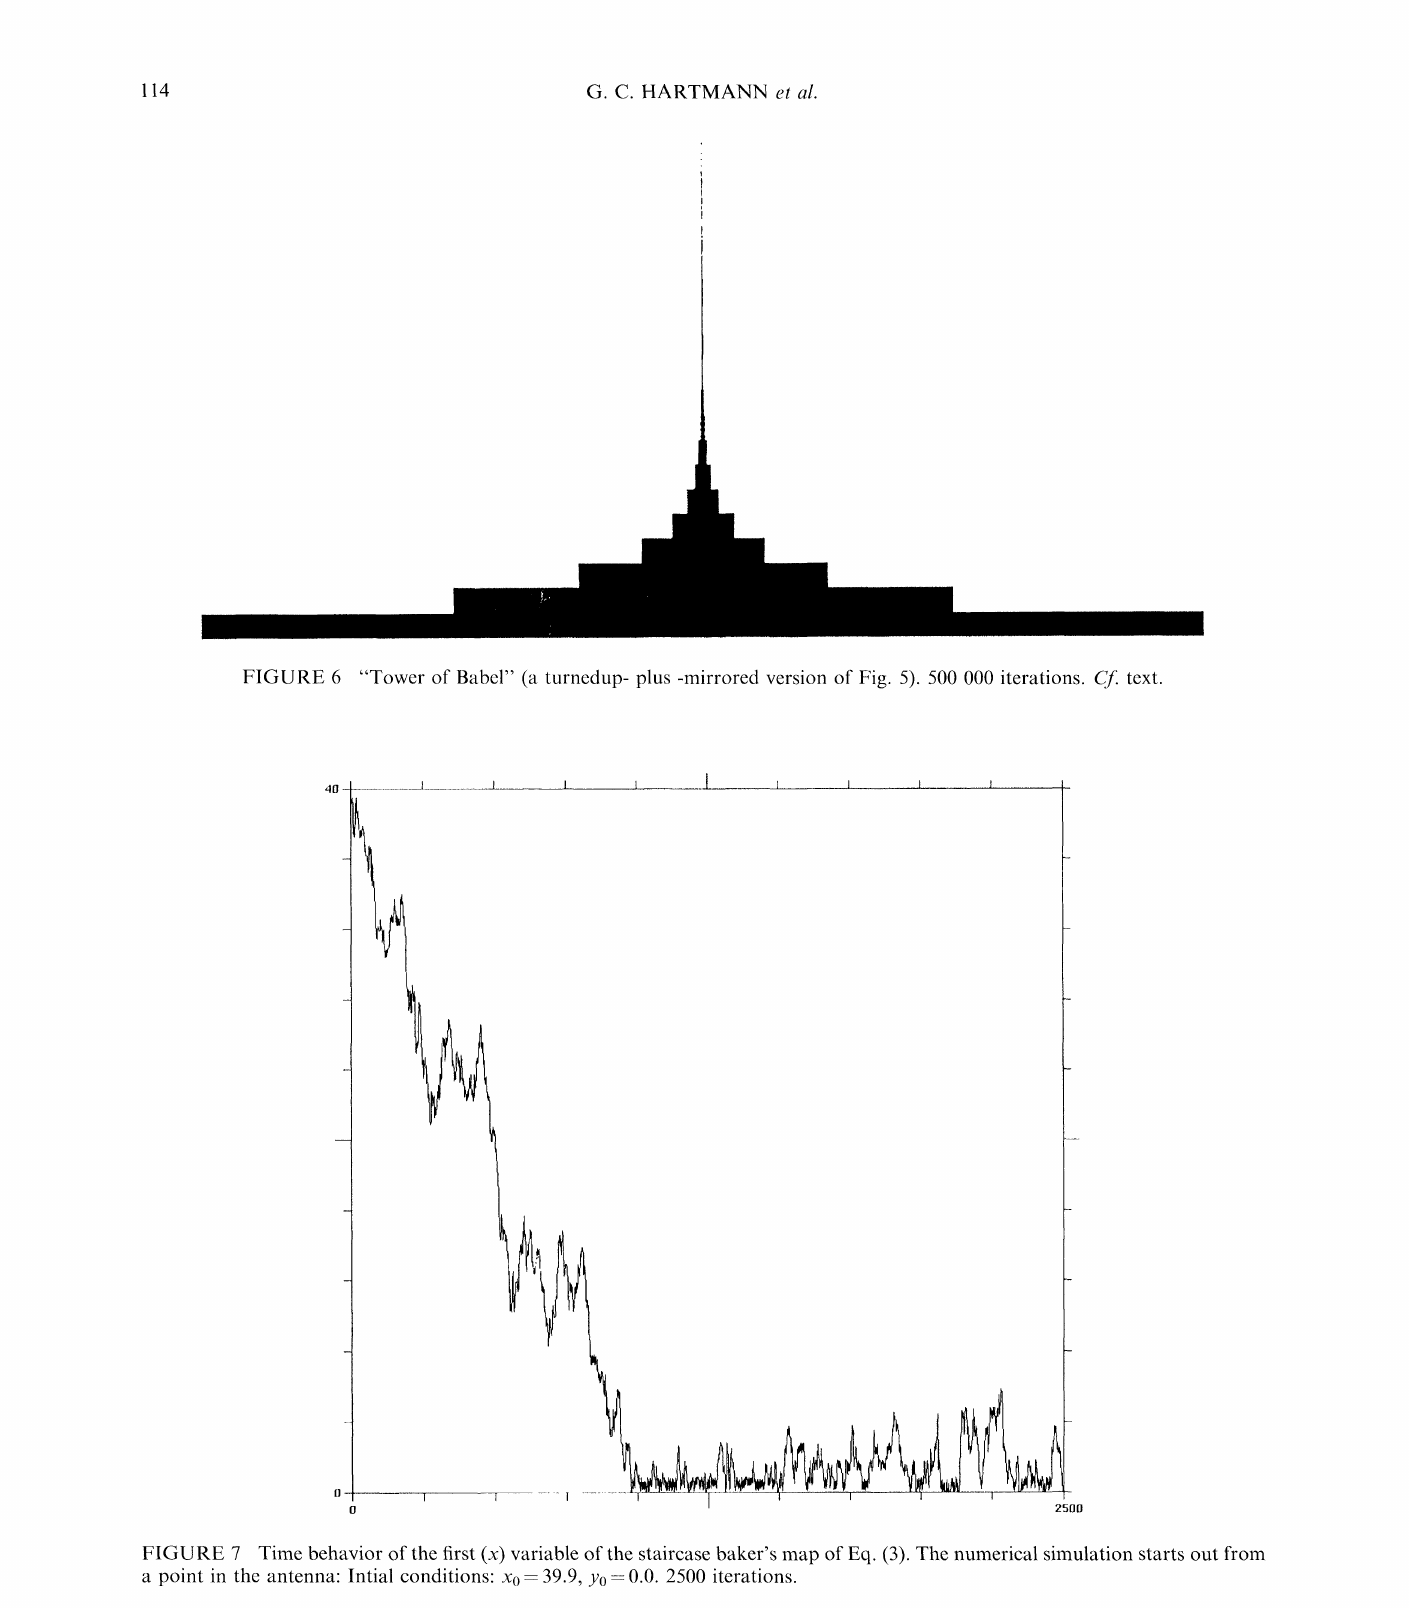
FIGURE 7 Time behavior of the first (x) variable of the staircase baker’s map of Eq. (3). The numerical simulation starts out from a point in the antenna: Intial conditions: x0-39.9, Y0 0.0. 2500